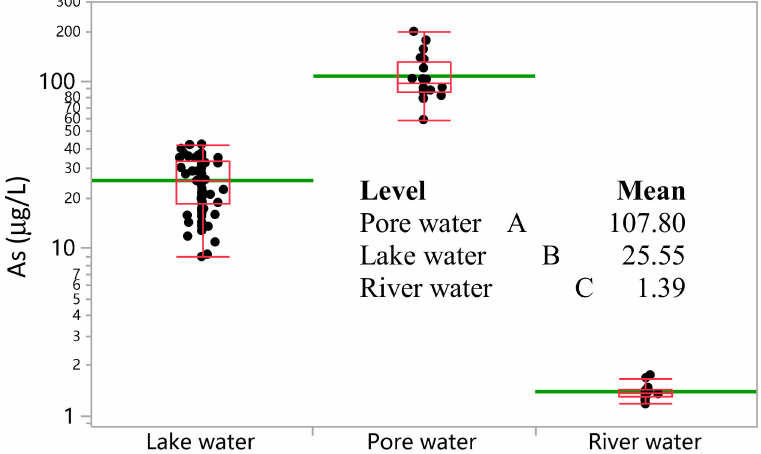
Figure 2. Comparisons of As levels in the lake water, river water and pore water. The average concentration of As(III) and As(V) were 0.35 µ g L − 1 and 1.04 µ g L − 1 for the river water, respectively, and 6.99 µ g L − 1 and 18.56 µ g L − 1 for the lake water (Table 2). This result indicated that As(V) was the predominant As form both in the lake and river water. In general, As(V) is the most prevalent dissolved form of As in an aerobic freshwater and saltwater environment [26]. The average concentration ratio of As(III) to As(V) was 0.34 for the river water and 0.42 for the lake water. In addition, As(III) concentration was more correlated to the total As concentration in the river water, while in the lake water As(V) concentration was more correlated with the total As concentration (Figure 3).